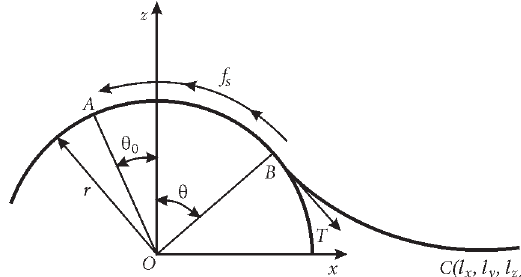
Fig. 2. Sliding effect between main cable and